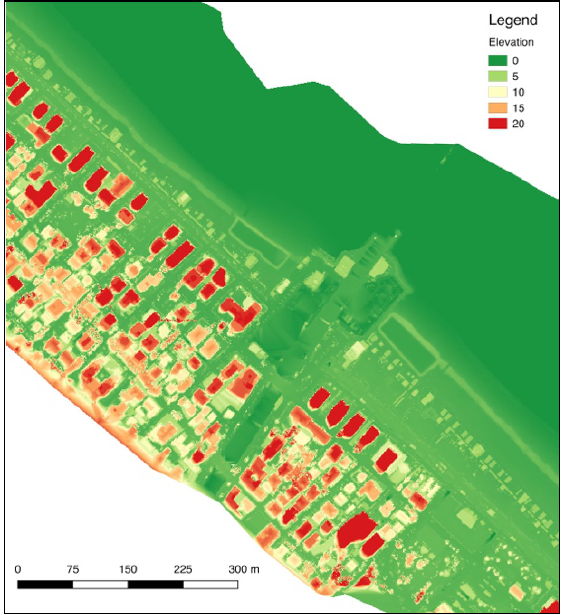
Figure 7. DSM from the processed LiDAR